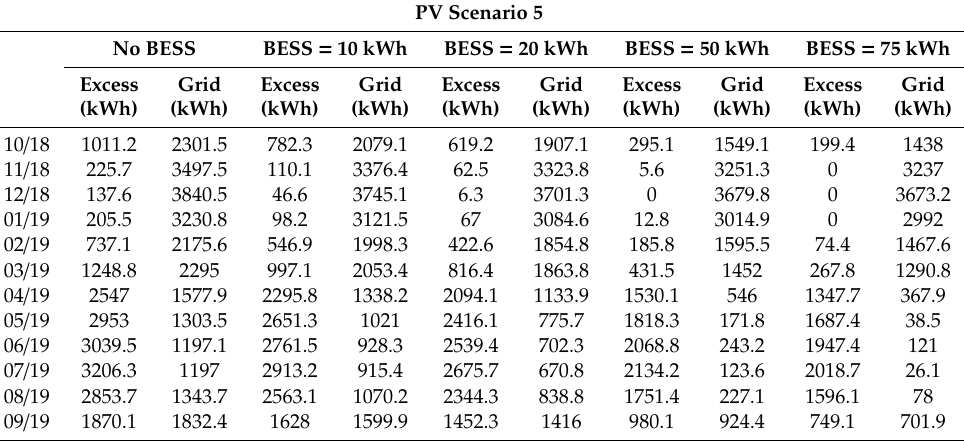
Table A5. Energy sent / taken to / from the grid considering various BESS capacities obtained for PV Scenario